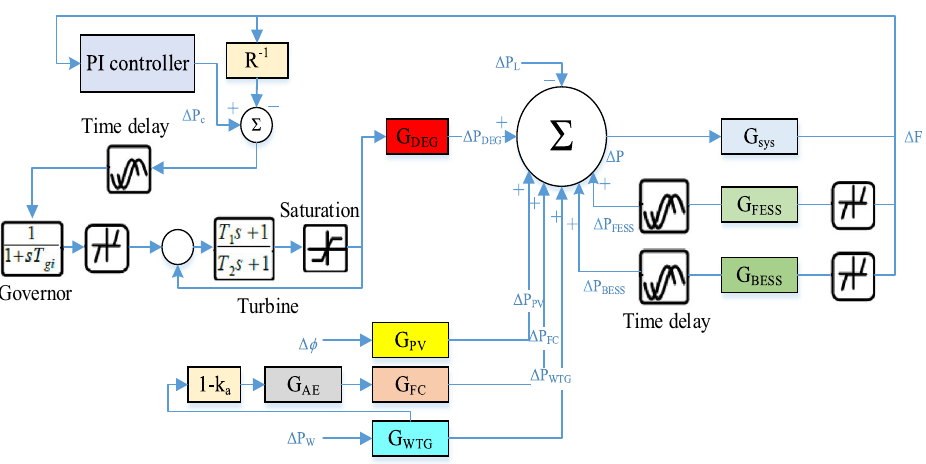
Figure 13. Microgrid frequency model considering physical